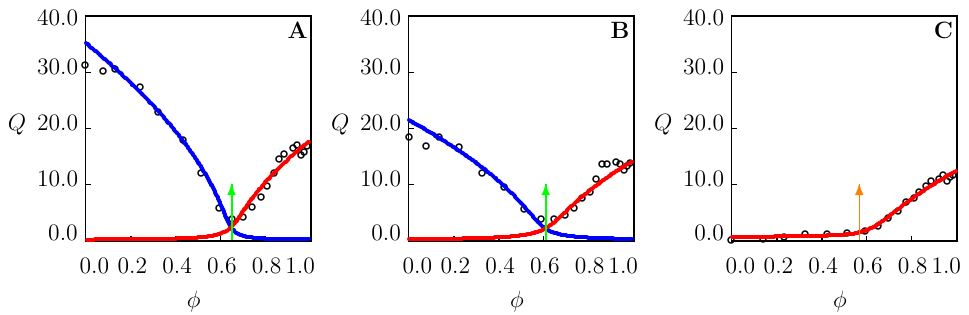
Figure 5. Equilibrium degree of swelling Q versus volume fraction of DMF φ in water/DMF mixture. Circles: experimental data [40] on PNIPAAm microgel at temperatures T = 5 ( A ), T = 20 ( B ), and T = 40 ◦ C ( C ). Solid lines: results of numerical analysis. Arrows indicate the volume phase transition